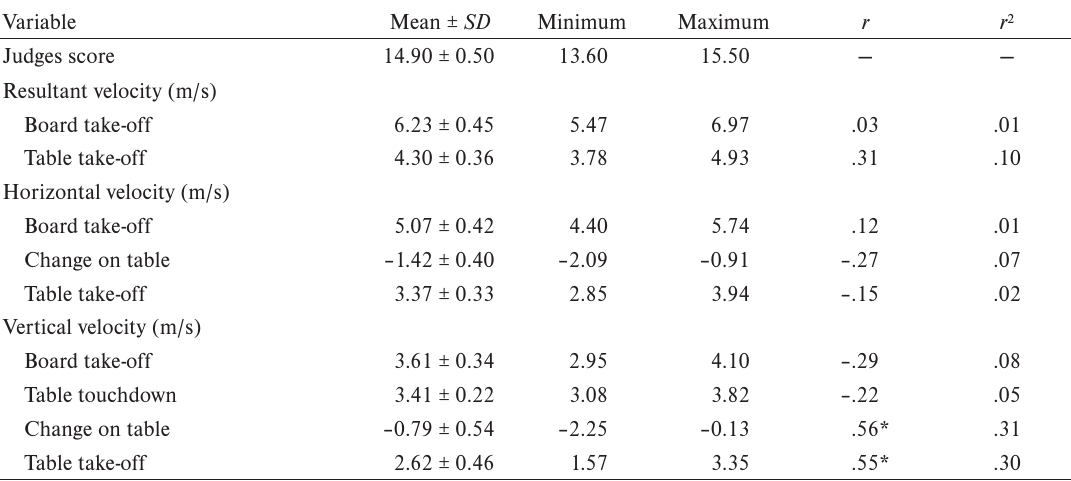
Table touchdown Change on table Table take-off Note. r = Pearson coefficient of correlation, r 2 = coefficient of determination. * p <